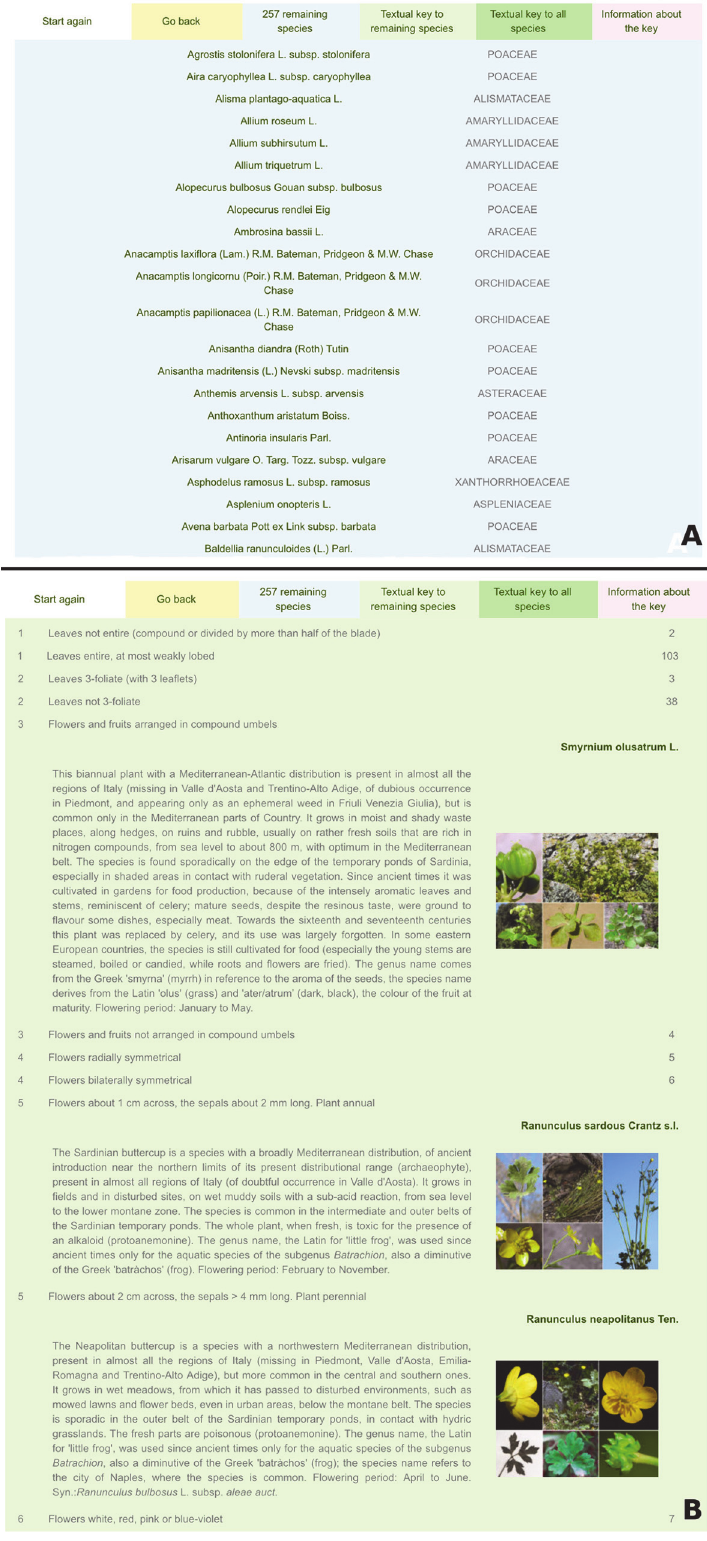
Fig 9. At each step of the identification process, users can list out the remaining taxa (a) or print an illustrated textual key